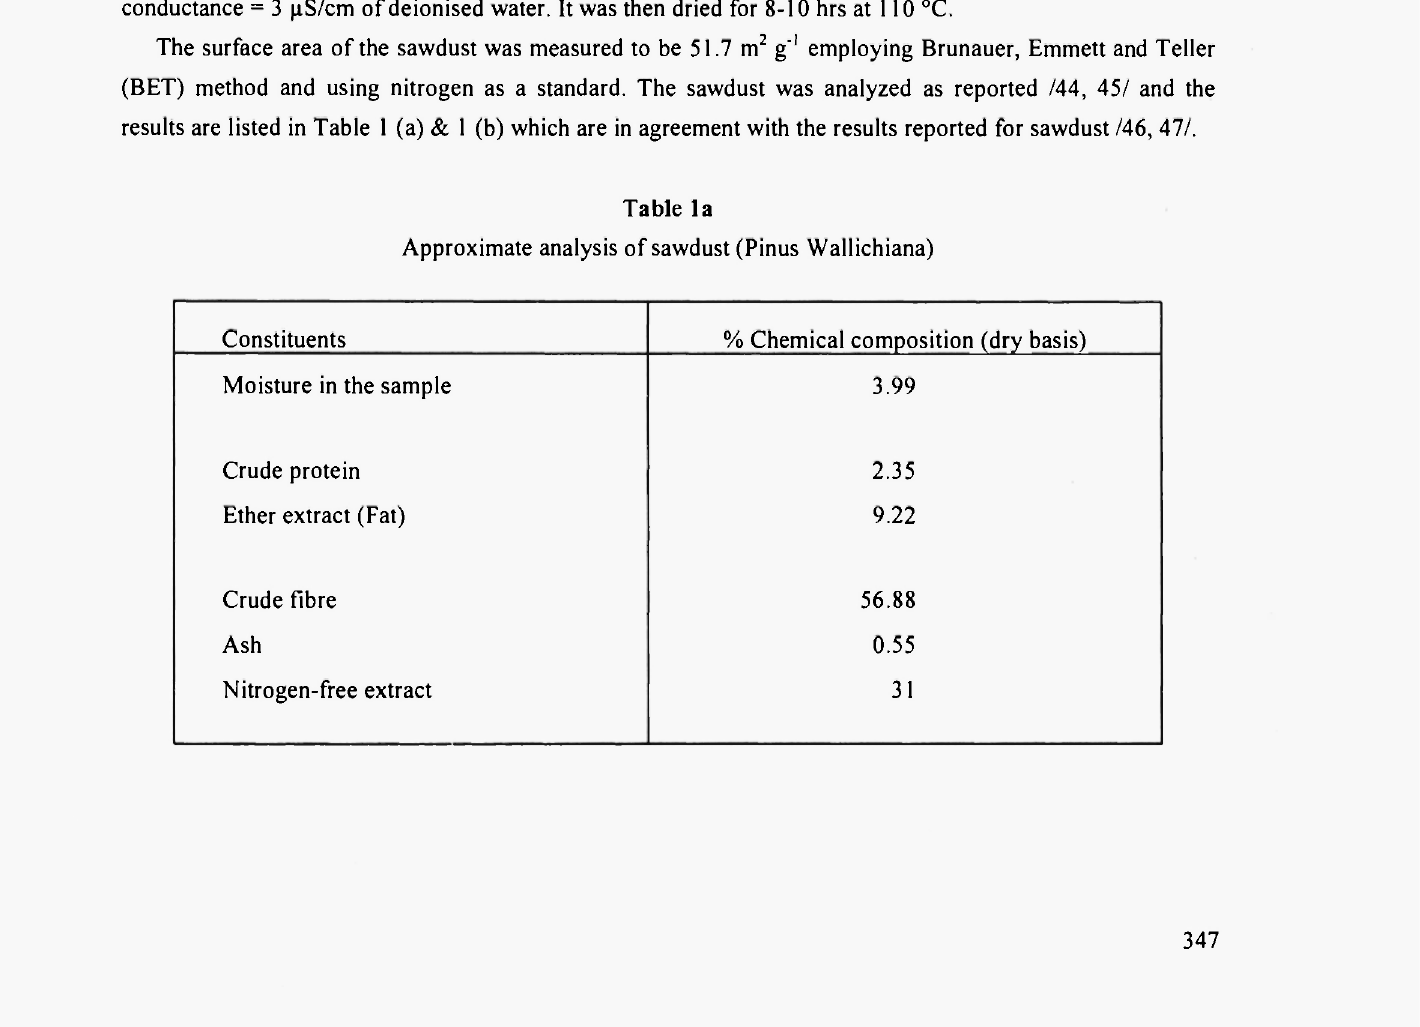
Approximate analysis of sawdust (Pinus